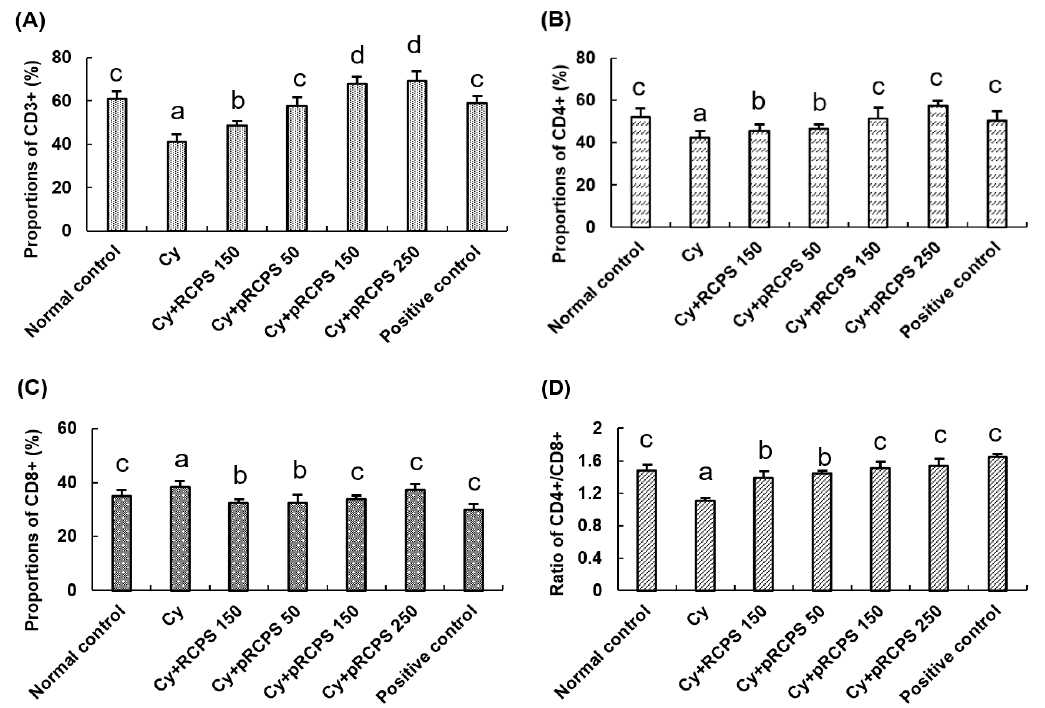
Figure 4. Effects of pRCPS on peripheral blood CD3+, CD4+, CD8+ cells, and on the ratio of CD4+ to CD8+ in Cy- immunosuppressed mice. After 24 h of the last treatment, blood samples were collected and the ( A ) CD3+, ( B ) CD4+, ( C ) CD8+ cells, and ( D ) CD4+/CD8+ were determined by FACS. Results are presented as the mean ± SD ( n = 10). The different letters (a–d) on a column differ significantly ( p < 0.05).